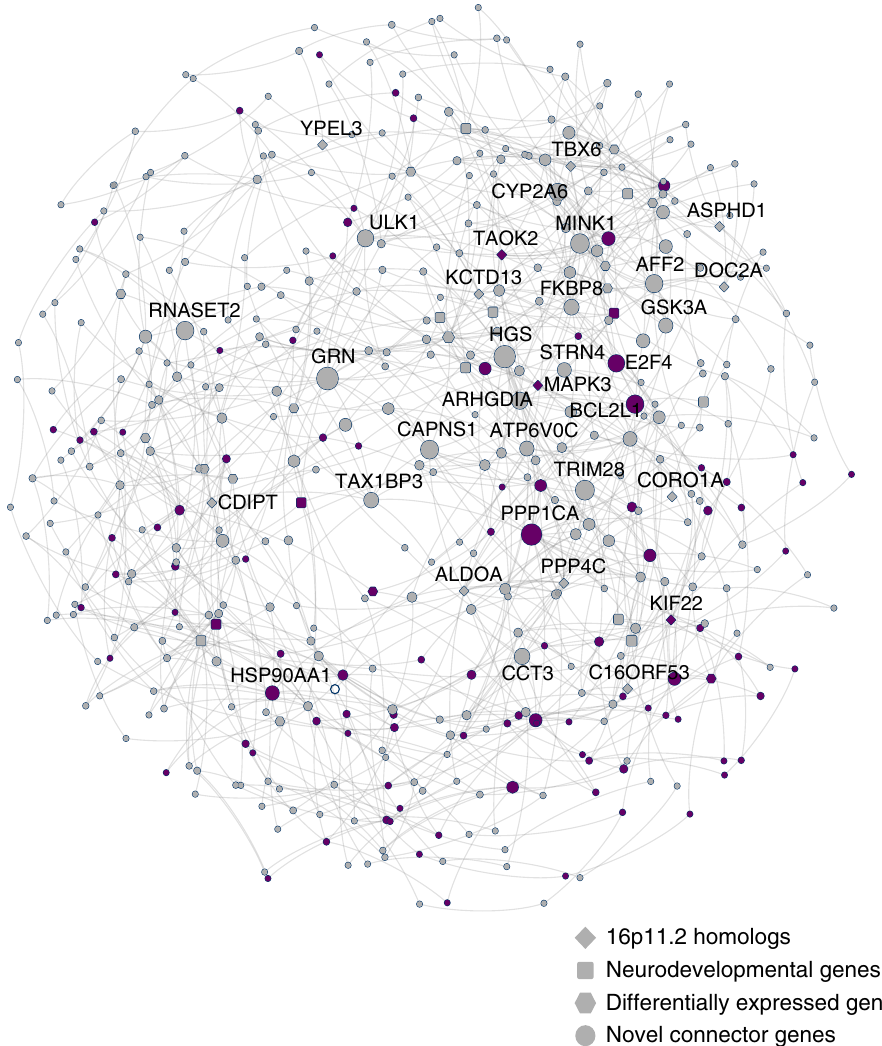
Fig. 9 Human brain-speci fi c network of 16p11.2 gene interactions. This network displays human brain-speci fi c genetic interactions of all tested 16p11.2 genes and modi fi er genes, as well as neighboring connector genes. Network nodes with thick borders represent tested genes, with node shape representing gene category. The size of the nodes is proportional to how many connections they have in the network, and the thickness of the edges is proportional to the number of critical paths in the network using that edge. Purple nodes are genes annotated with cell proliferation or cell cycle GO